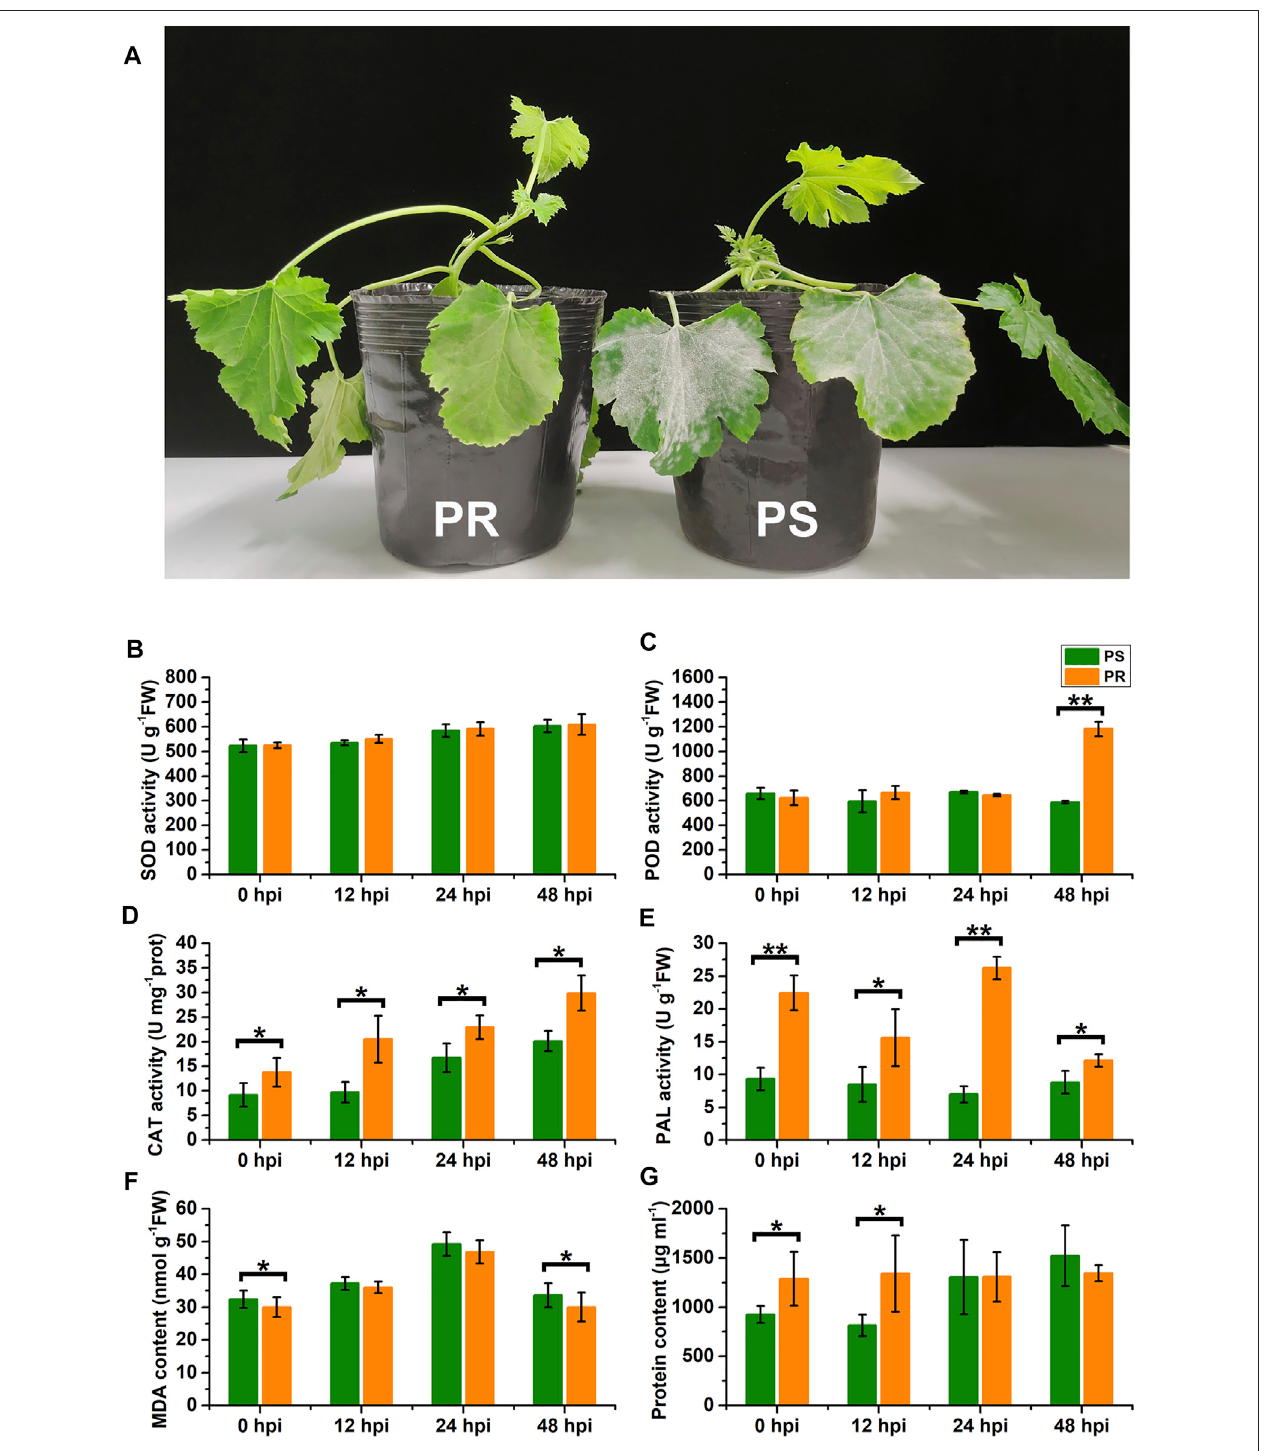
FIGURE1| Effectsofpowderymildewinoculationonphysiologicalcharacteristics. (A) Differentphenotypesofsusceptibleandresistant C.pepo at7 daysafterPM inoculation. (B – G) Changes in superoxide dismutase (SOD) activity, peroxidase (POD) activity, catalase (CAT) activity, phenylalanine ammonia-lyase (PAL) activity, malondialdehyde(MDA)content,andtotalproteinconcentrationwithinleavesof C.pepo 0,12,24and48 hpostPMinoculation.PSrepresentsPM-susceptible C.pepo and PRrepresents PM-resistant C.pepo .Errorbarsindicatestandarddeviationsamongthreebiologicalreplicates( n =3). Asterisksindicate signi fi cantdifferences between PS and PR ( “ * ” represents p < 0.05; “ ** ” represents p < 0.01).